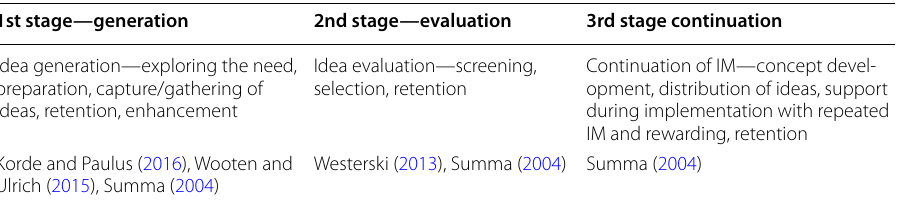
Table 1 Idea management stages (IMS). Source: developed by the authors based on Mikelsone et al.